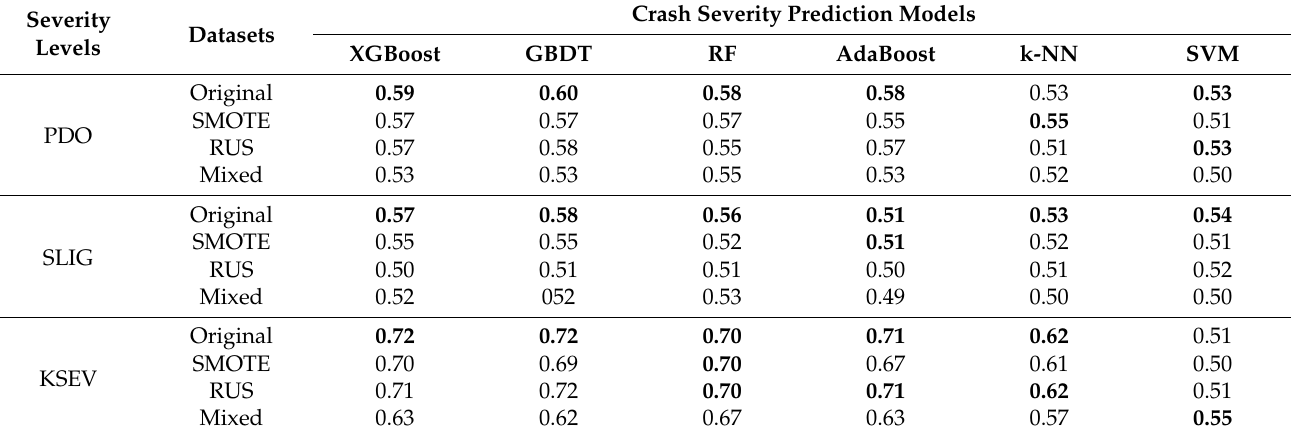
Table 4. Overview of AUC Using Different